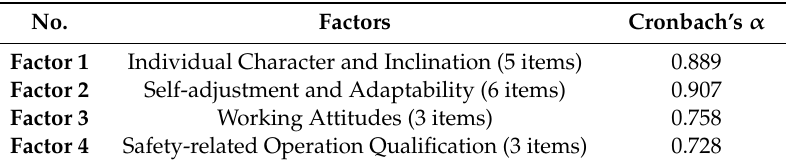
Table 7. Cronbach’s α reliability test of identified factors.